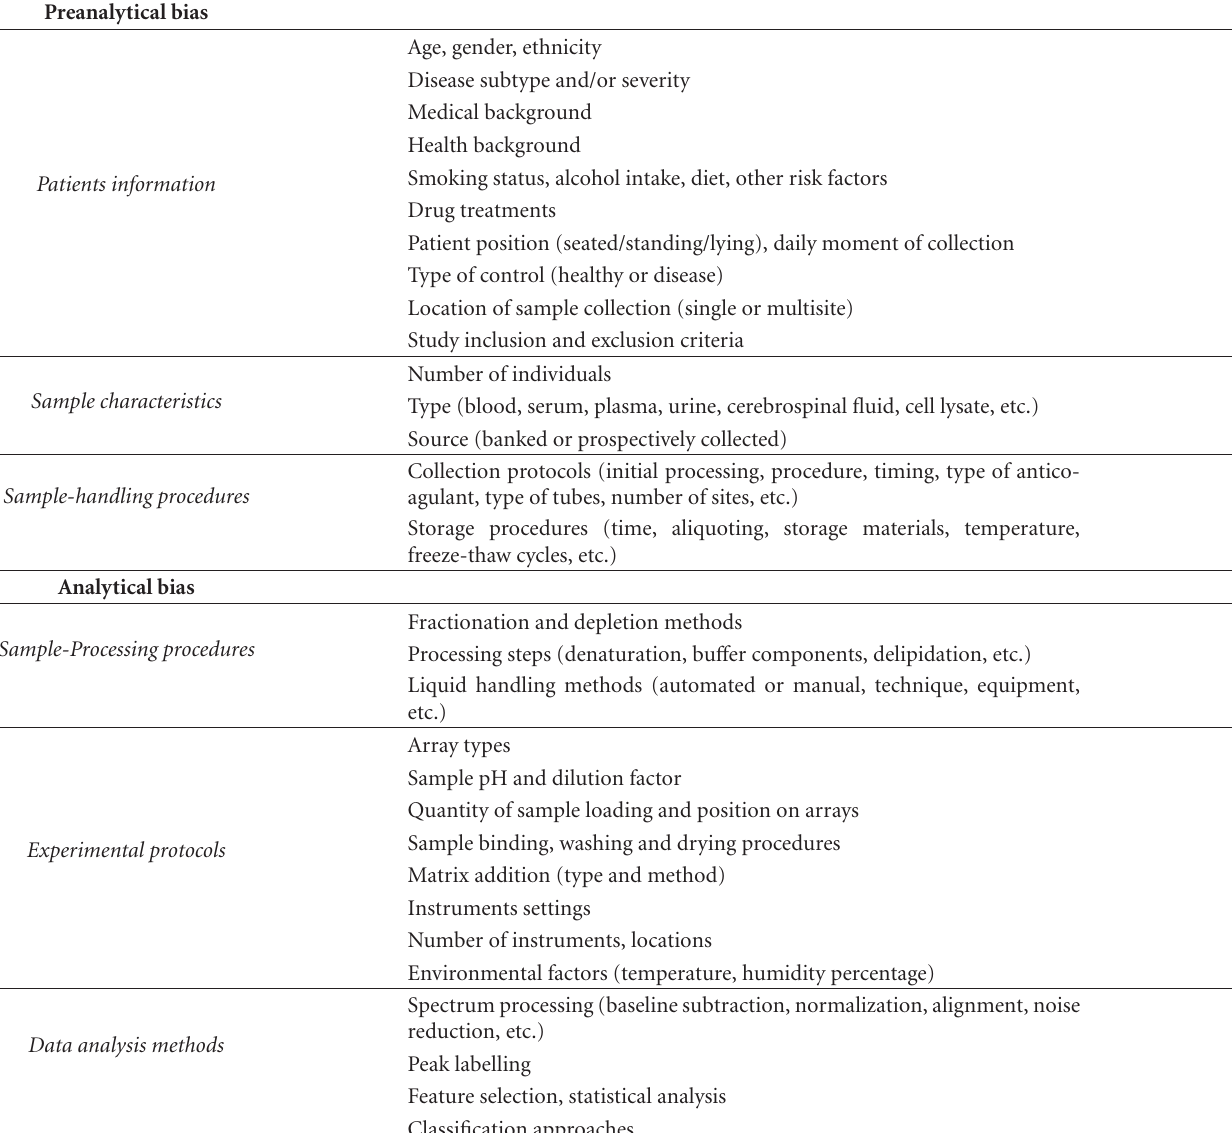
Table 1: Factors that impact preanalytical and analytical